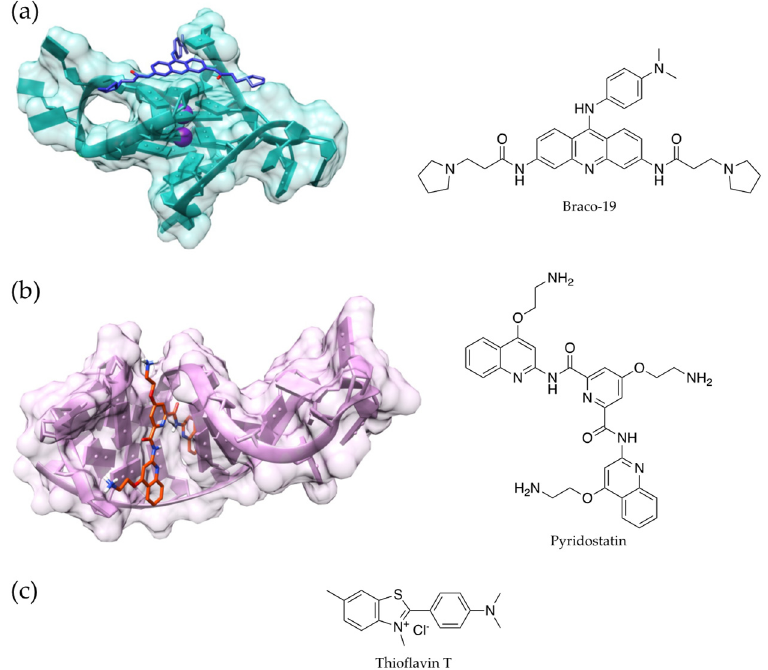
Figure 4. Chemical structure and 3D model of a ligand-G4 DNA complex for Braco-19 (PDB ID 3CE5, ( a ) and pyridostatin (PDB ID 7X3A) ( b ); chemical structure of thioflavin T ( c ).